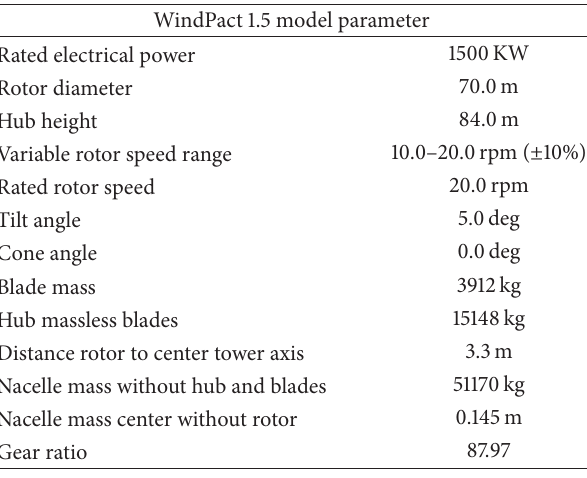
Figure 11: Tested wind profile.